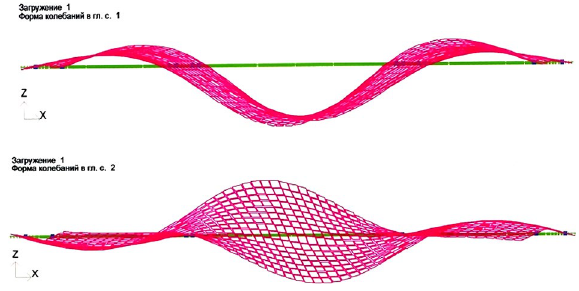
Fig. 17. Natural frequency dependence on loaded length Fig. 18. 1 st and 2 nd mode shape for bridge over Divaja